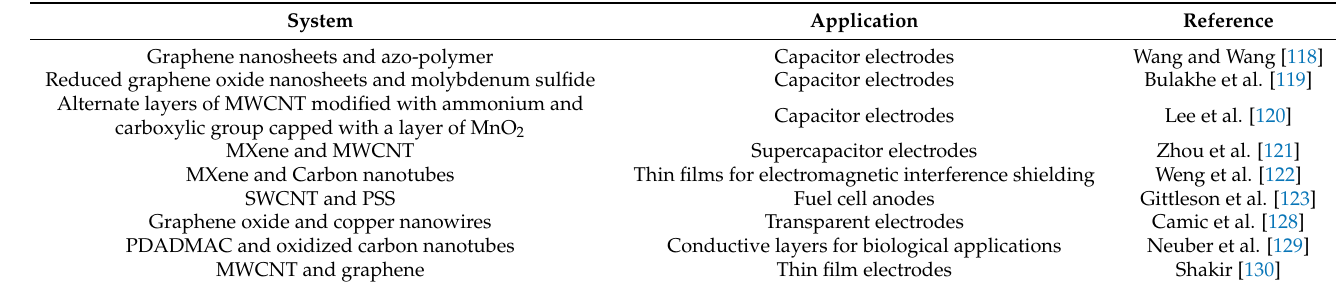
Table 2. Examples of LbL structures containing carbon nanomaterials and their potential